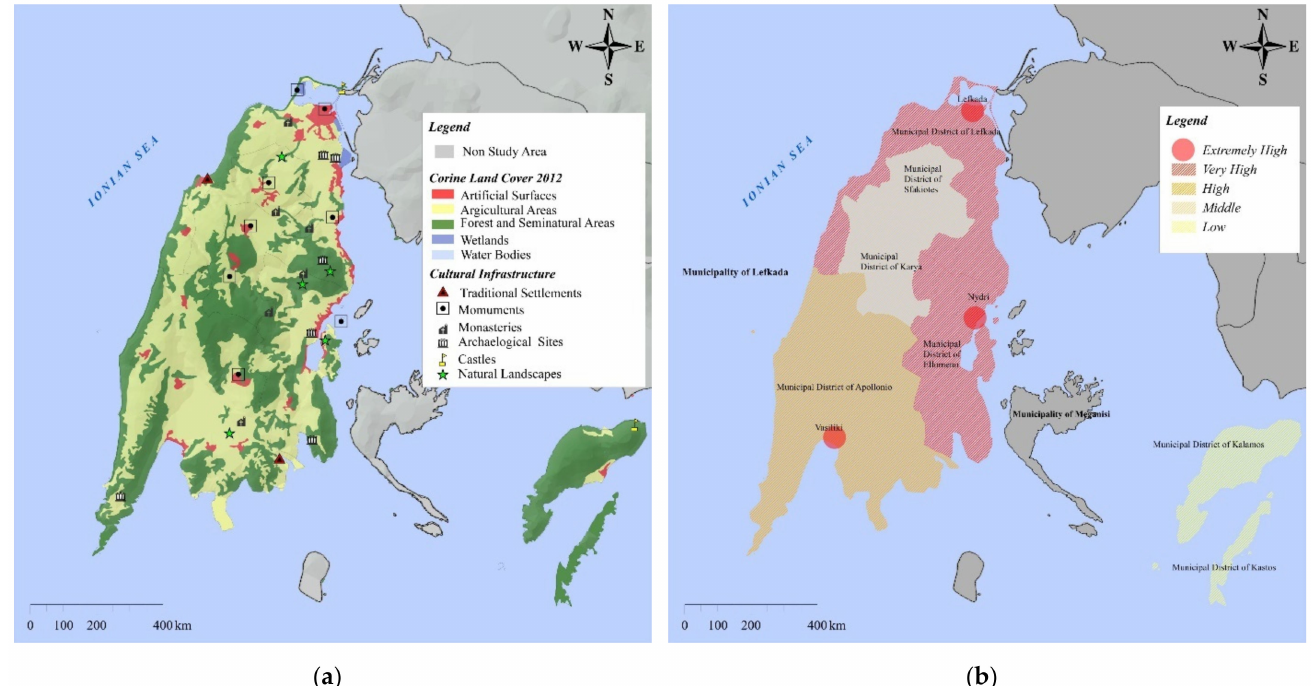
Figure 2. Maps depicting: ( a ) land uses and cultural infrastructure in the study area and ( b ) levels of tourism concentration based on hotel accommodation and tourist